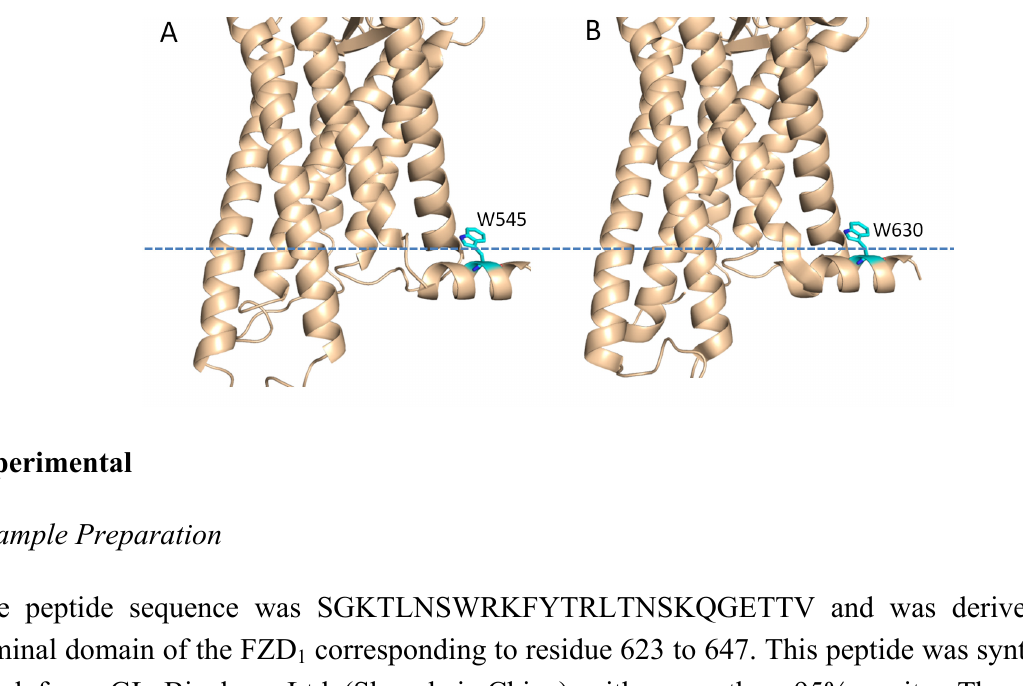
Figure 5. Role of the Trp residues in membrane binding. A. Crystal structure of the SMO receptor. B. Homology model of the FZD using the crystal structure of the SMO receptor 1 as a template [25]. The possible membrane interface is shown in dash line. The residues in both structures are shown in